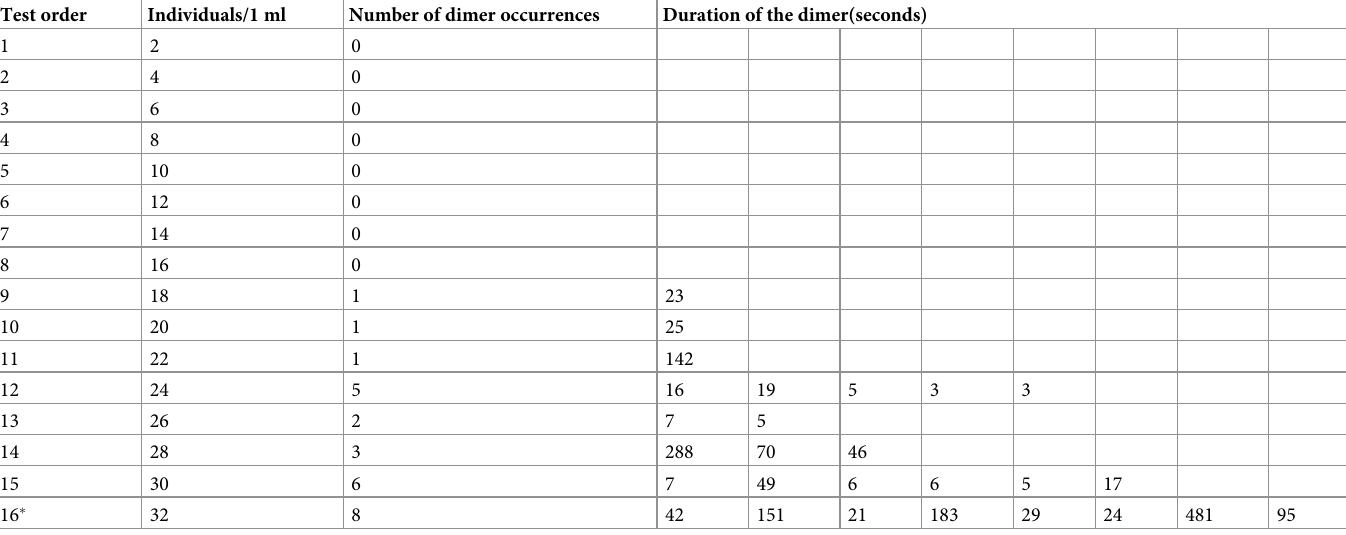
Table 2. Number and duration of dimer occurrences in ten